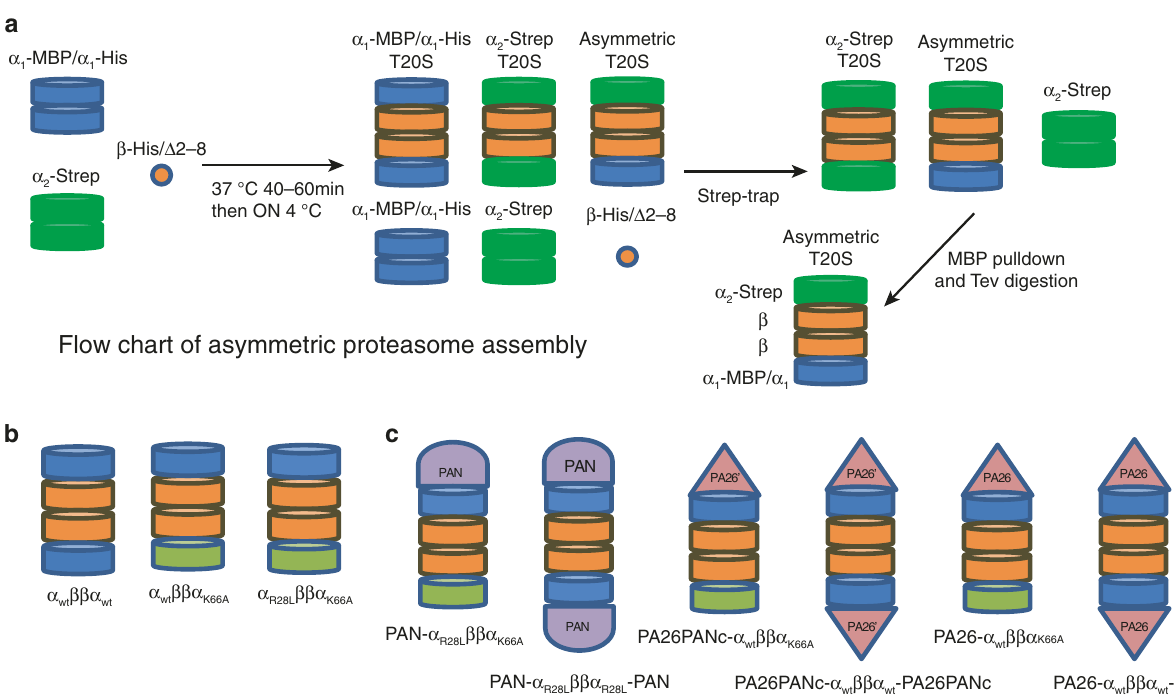
Fig. 1 Scheme for in vitro assembly of asymmetric proteasome. a Schematic fl owchart of asymmetric 20S CP in vitro assembly and puri fi cation. Following assembly of the depicted mixed population, the intended asymmetric particles were puri fi ed by a two-step af fi nity puri fi cation scheme. b Schematic illustration of the types of in vitro assembled asymmetric 20S CPs used in this study. c Schematic illustration of all types of RP-capped complexes assembled and used in this